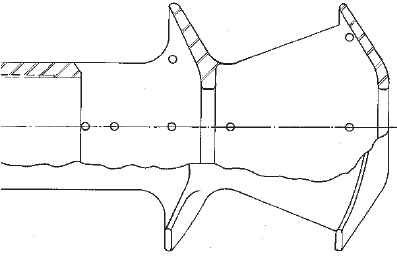
Fig. 5. M109 muzzle